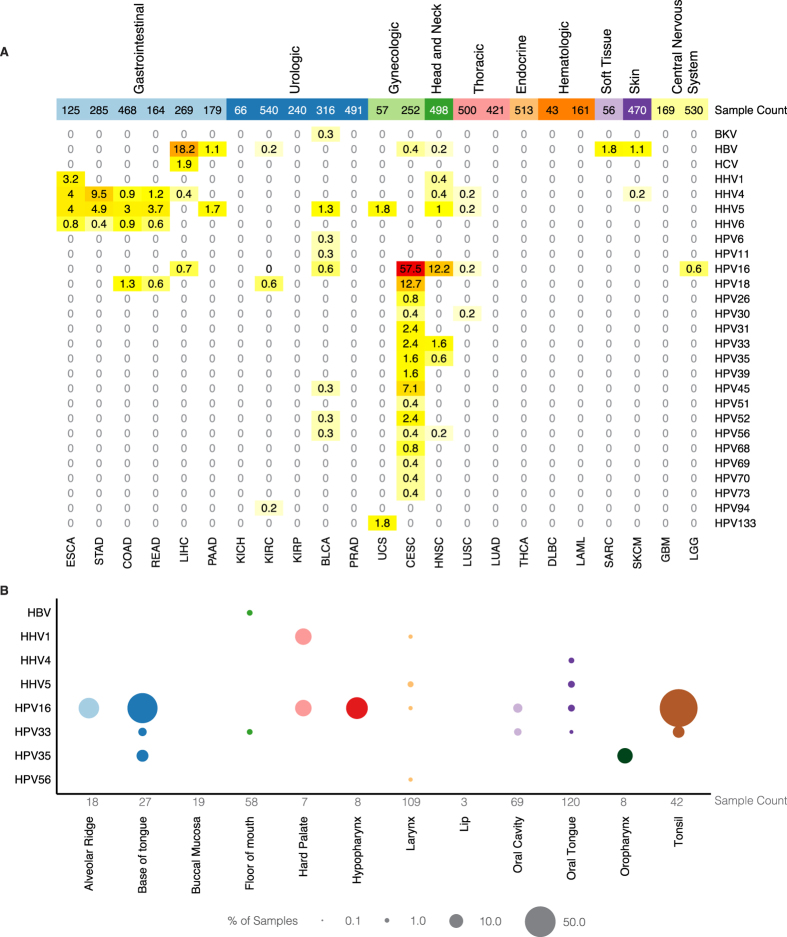
The detected frequency of various viruses across 23 cancer types, classified across (A) 10 different organ systems and (B) 12 different HNSC anatomic sites. The top number in (A) is the total number of samples in the given cancer type and the bottom number in (B) is the number of samples by anatomic site in head and neck cancers. In (B), circle area is proportional to frequency. The full name of each cancer type in (A) can be found in Materials and Methods.